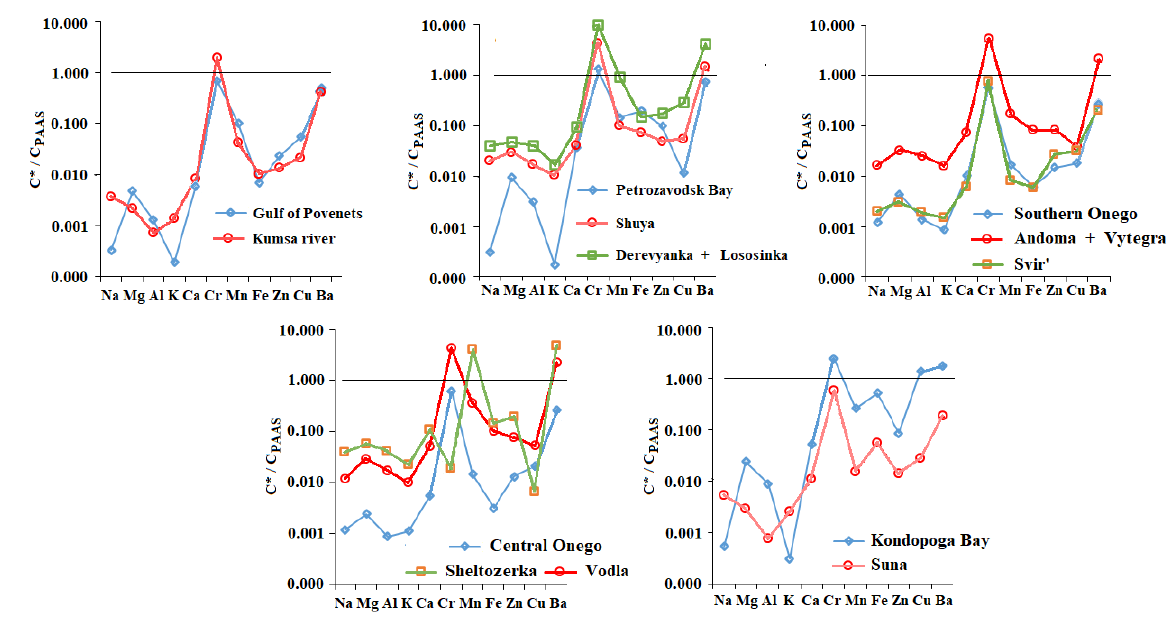
Figure 12. The distribution of the content of elements in the suspended matter of water in the estuaries of the rivers and their corresponding areas of Lake Onego, normalized to the content in PAAS [45]. C* — the concentration of the element in the suspended matter.